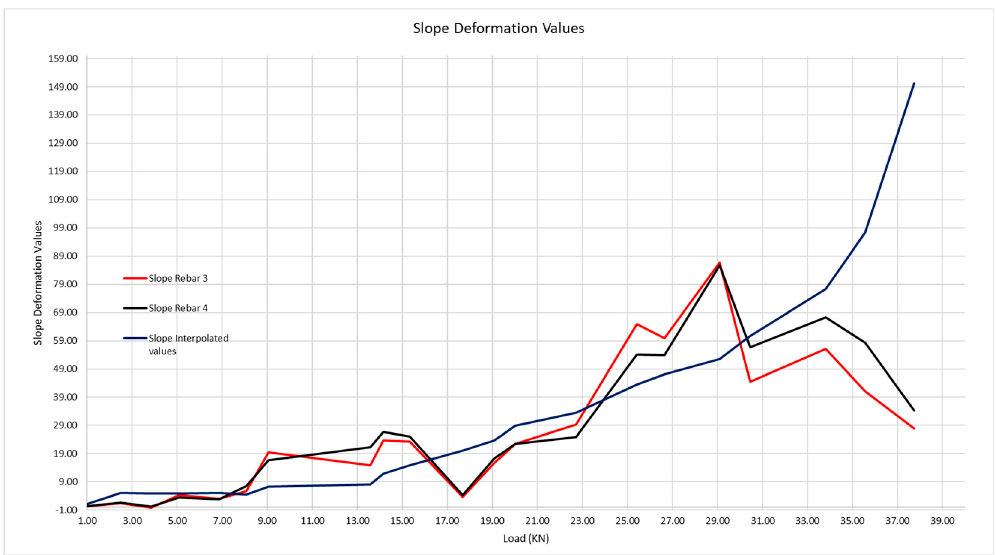
Figure 18. Slope curves of the theoretical deformation of the corrugated steel (interpolated values) and of rebars 3 and 4.